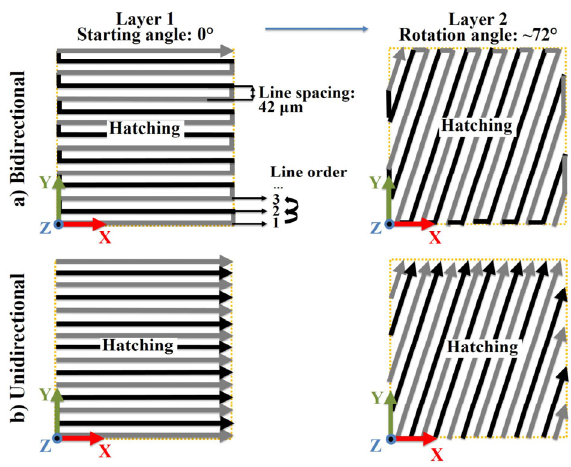
Figure 3. Schematic of the default scanning strategy with a starting angle of 0° and a rotation angle of ~72°: with ( a ) bidirectional and ( b ) unidirectional scanning.